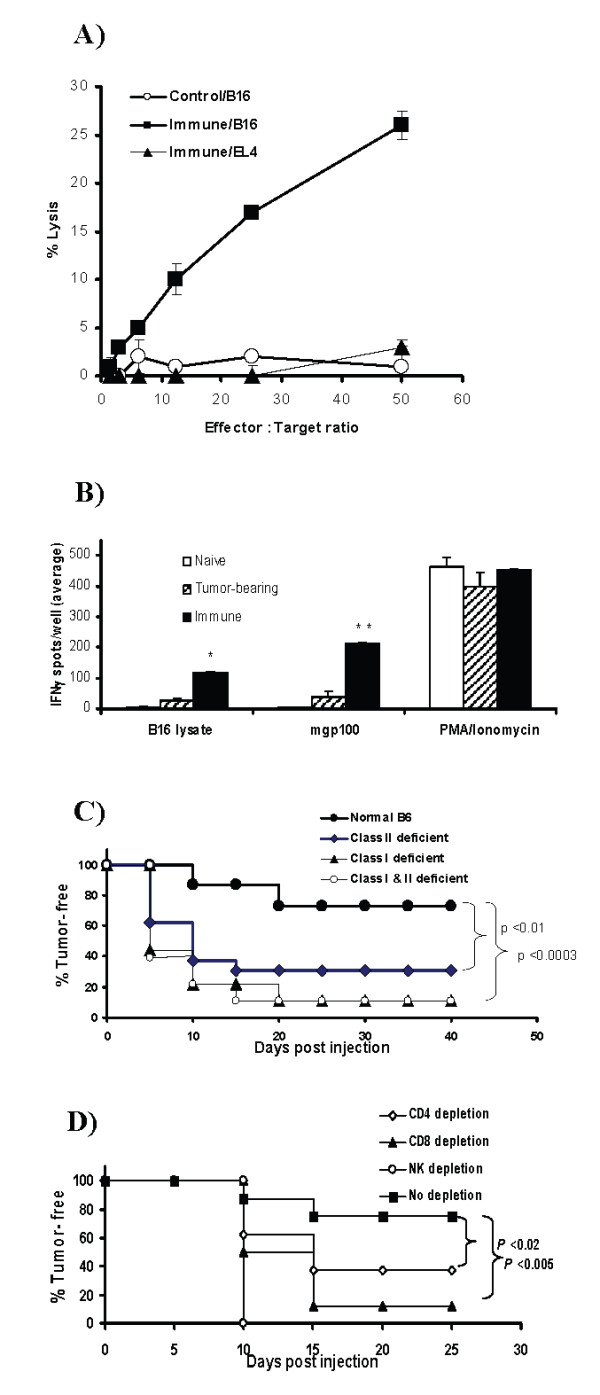
TSA-treated B16 vaccine elicits cytotoxic and IFN-γ-producing lymphocytes and requires T and NK cells in immunity. A) T-cell-enriched splenic lymphocytes isolated from immune or control mice after in vitro re-stimulation were analyzed in triplicate for cytotoxic activity using 51Cr-labeled untreated B16 or EL4 as targets. B) Splenocytes isolated from immune, B16 tumor-bearing or naive B6 mice were cultured in anti-IFN-γ coated plates with B16 cell lysate or melanoma antigen mgp10025–33 peptide and IFN-γ secretion was detected by ELISpot assay. *, p <0.0008 (cell lysate stimulation) and **, p <0.03 (peptide stimulation) compared with splenocytes from tumor-bearing mice. PMA and Ionomycin treated splenocytes served as positive control. These experiments (A and B) were repeated 3 times with similar results. C) Reduced incidence of TSA-treated (500 nM for 48 h) B16 tumor rejection in MHC deficient mice that lack CD4+ and/or CD8+ T cells compared with immunocompetent mice. The Kaplan-Meier plot shows tumor-free survival of class II-/- (n = 16), class I-/- (n = 18), class I-/--II-/- (n = 18) and immunocompetent B6 (n = 15) mice after s.c. vaccination with TSA-treated B16 (1 × 105 cells). D) Depletion of CD4+, CD8+ T cells and NK cells reduces immunity generation by TSA-treated B16 cells. B6 mice were depleted of CD4+ (n = 16), CD8+ (n = 8) T cells or NK cells (n = 8) by repeated injection of respective antibodies (see Methods). Undepleted controls (n = 16) received IgG. All mice were observed for tumor growth after s.c. vaccination with TSA-treated B16 cells in the trunk.